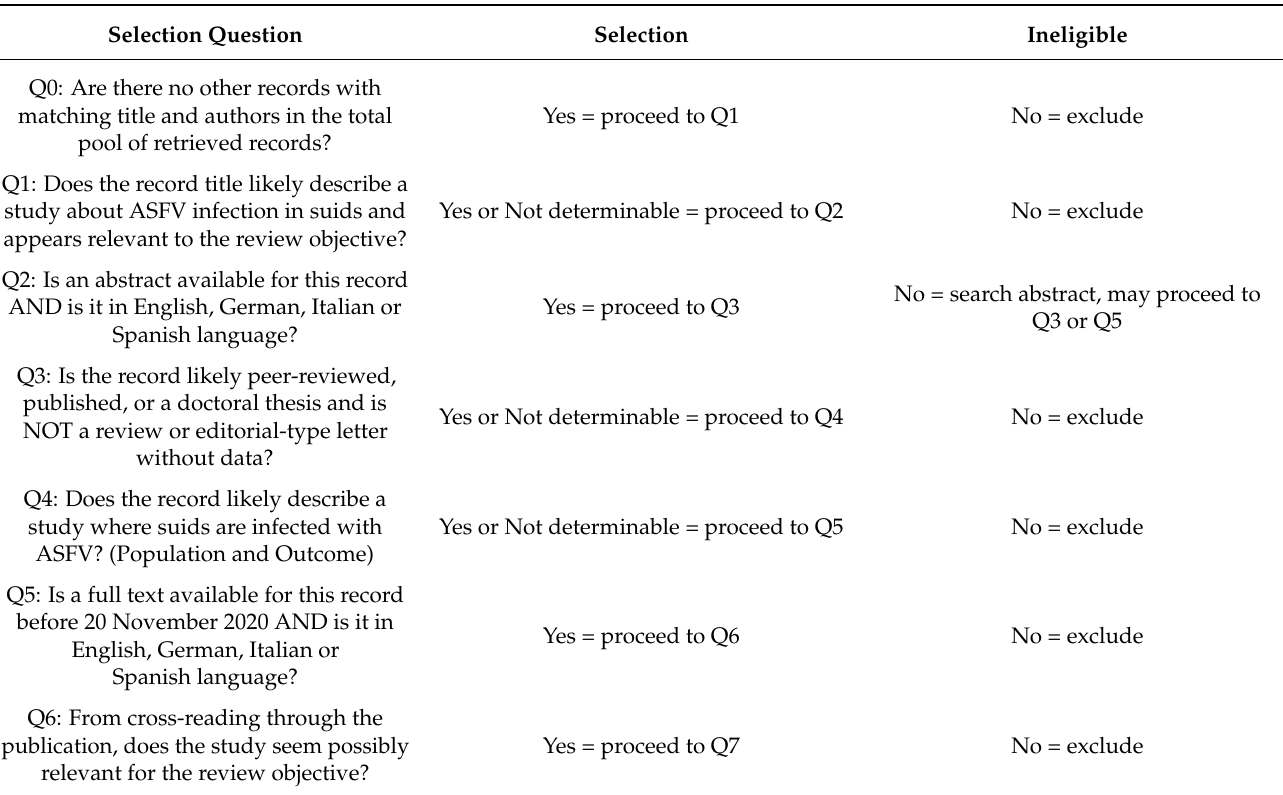
Table 1. List of inclusion and exclusion criteria for sequentially applied literature selection steps. Selection questions were consecutively applied to all records during the literature screening